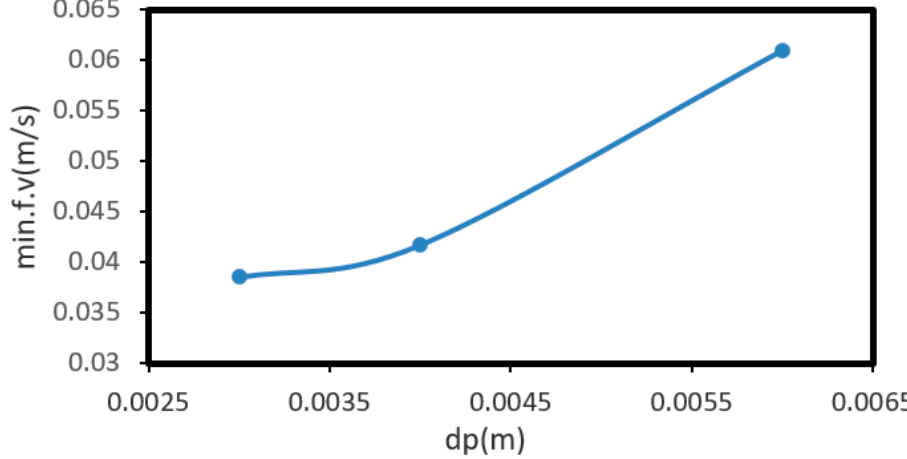
Figure 4. Variation of minimum fluidization velocity with different particle diameters.